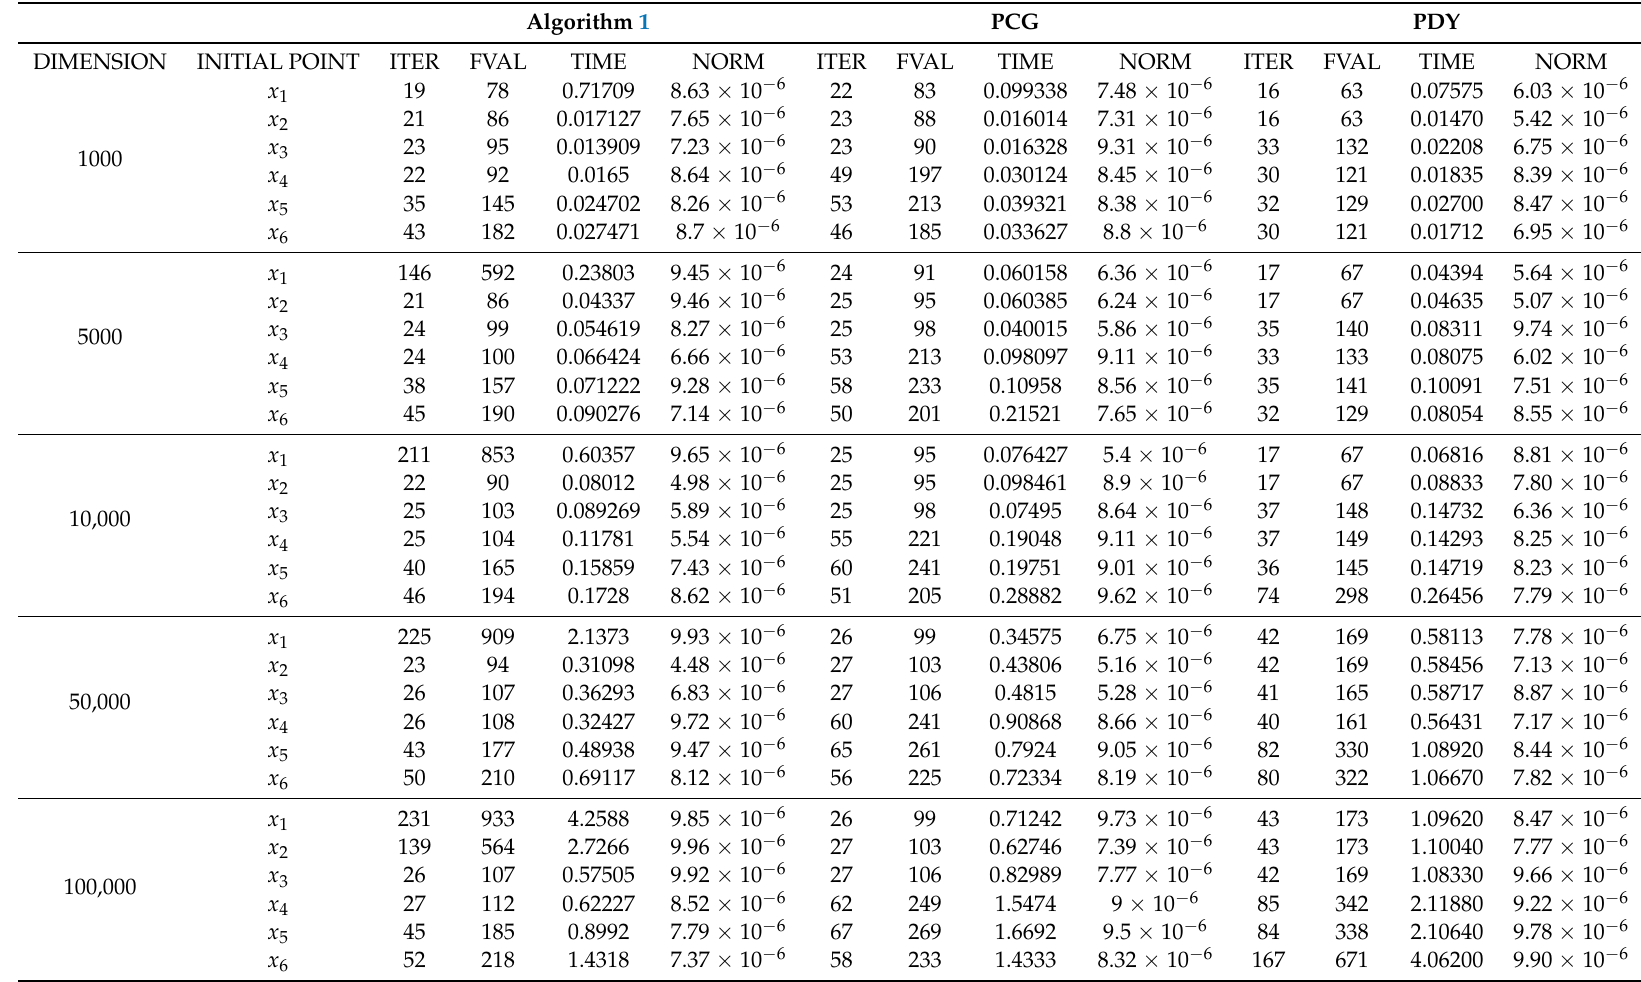
Table 5. Numerical Results for Algorithm 1 (DCG) , PCG and PDY for Problem 5 with given initial points and